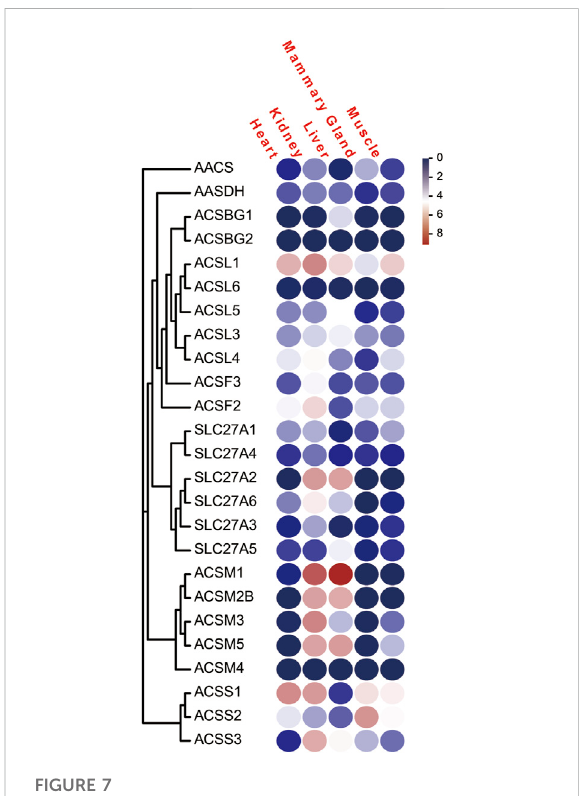
FIGURE 7 The FPKM of the of ACS genes of the dairy goat in fi ve differenttissues. Legends:The heat map wascreated with thelog- transformed values of the FPKM values of ACS genes. Color gradient from navy-white-red indicates expression values change from low to